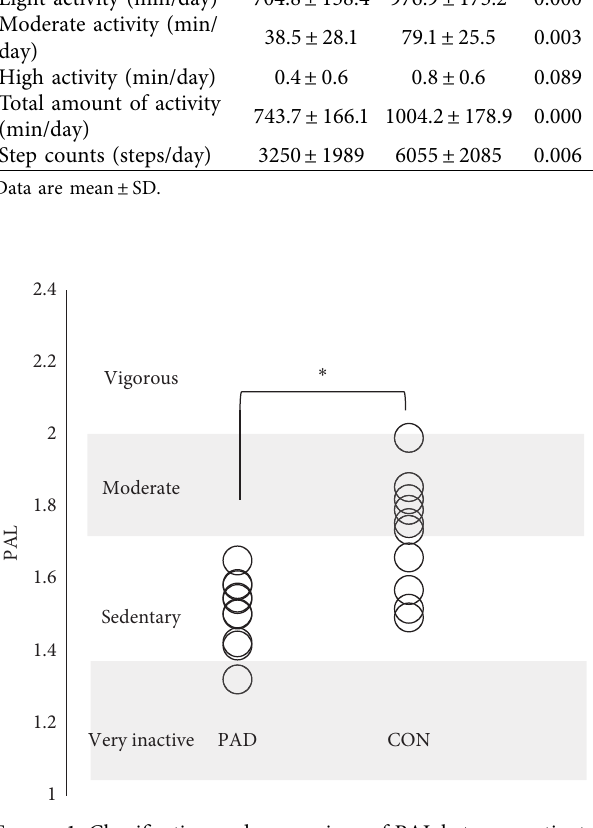
Figure 1: Classification and comparison of PAL between patients with PAD and control subjects (CON). ∗ P < 0 . 001 between PAD and CON. PAL, physical activity level; PAD, patients with pe- ripheral artery disease; CON, healthy control subjects.